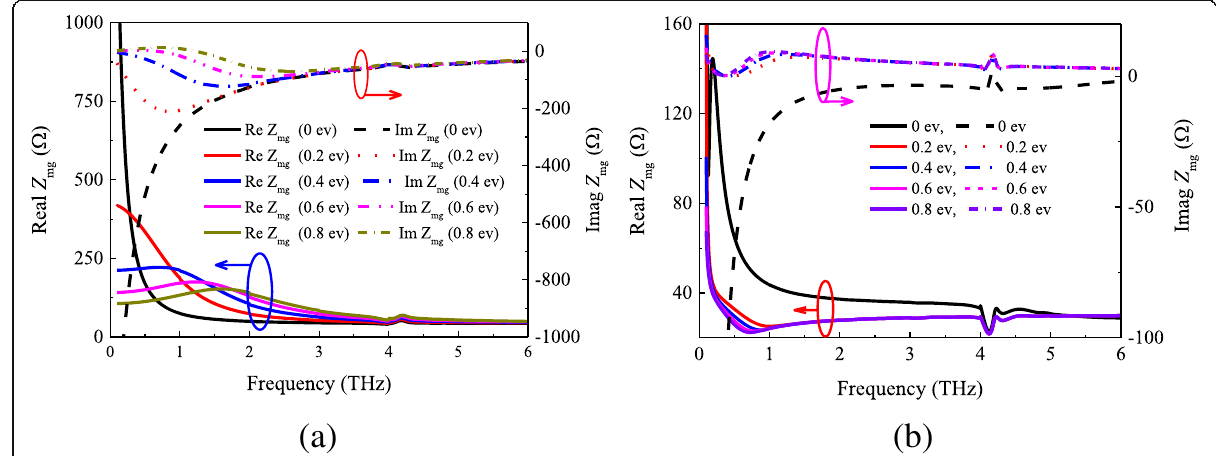
Fig. 5 Metasurface-graphene film impedance Z mg with different chemical potentials. a Analytical and b simulated results